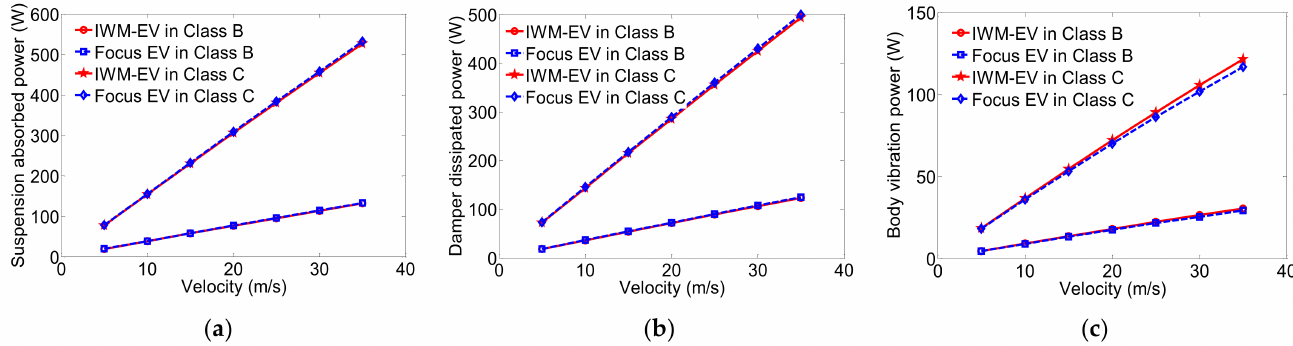
Figure 4. Energy flow from wheel to the body: ( a ) Suspension absorbed power; ( b ) Damper dissipated power; ( c ) Body vibration power.